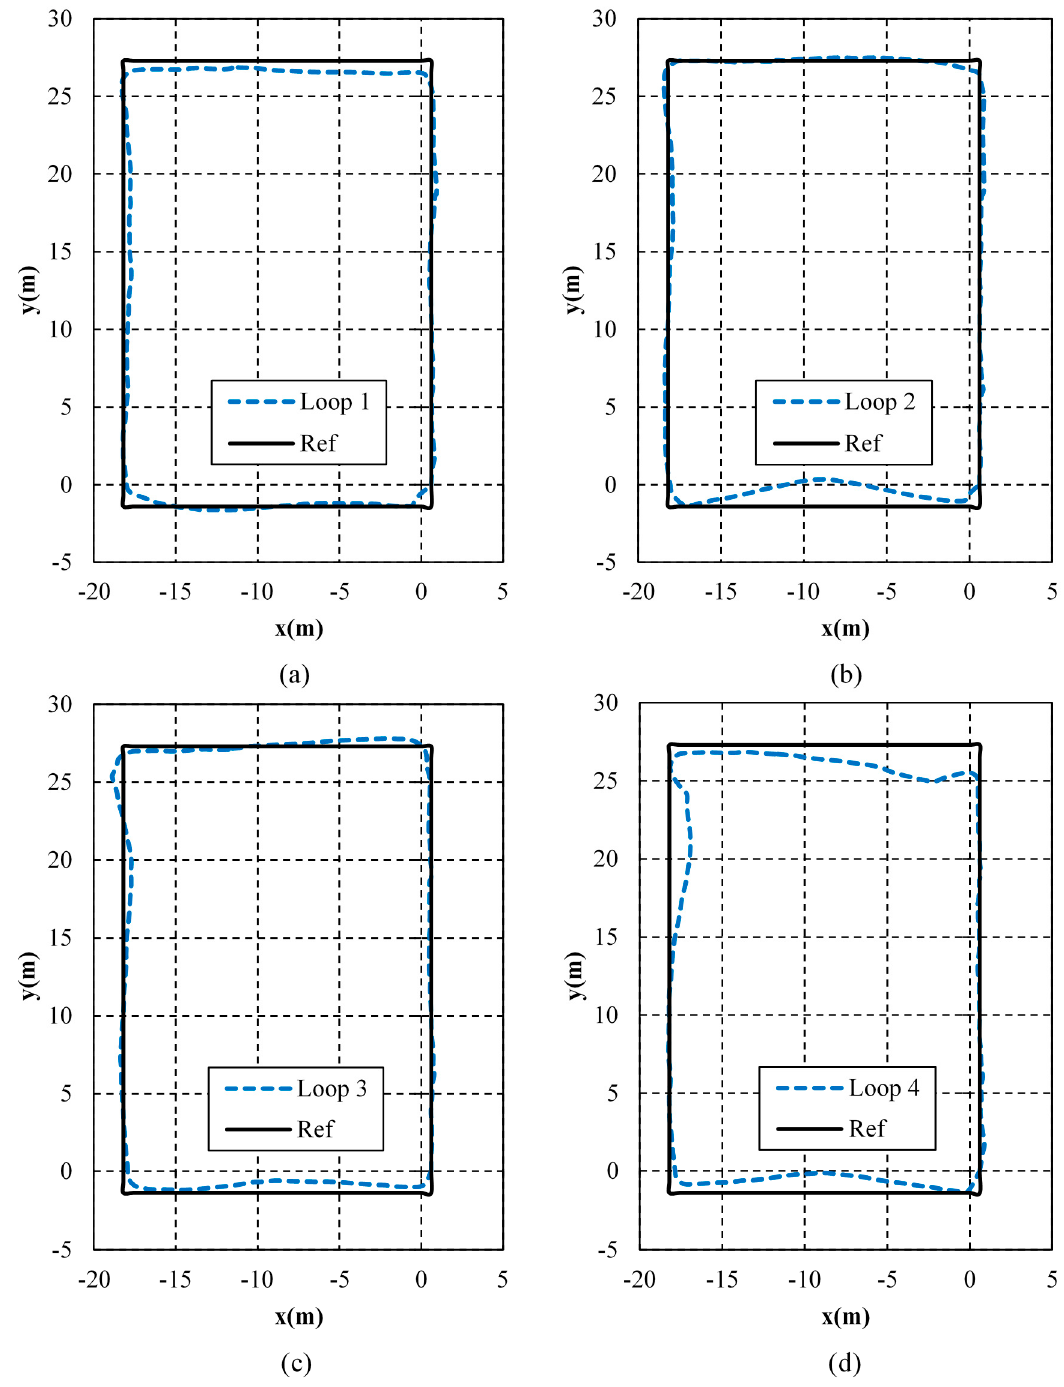
Figure 14. Positioning results in different loops. ( a ) Loop 1; ( b ) Loop 2; ( c ) Loop 3; ( d ) Loop Table 6. Positioning errors in different loops.